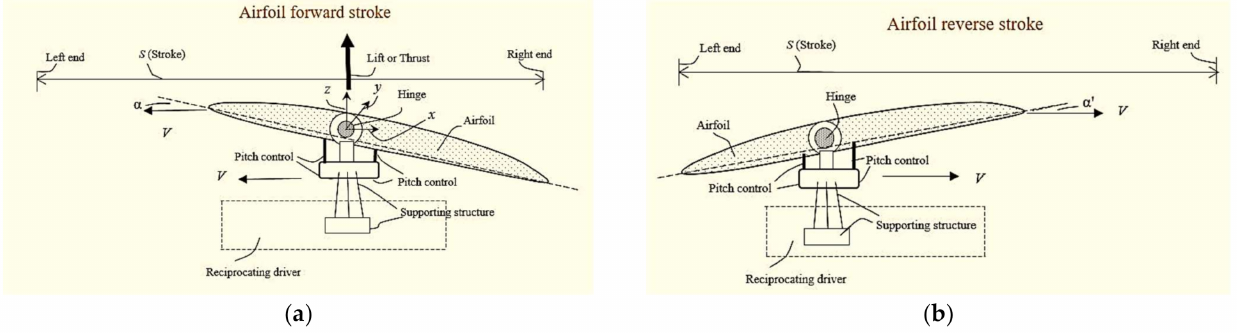
Figure 4. Schematic illustration of a reciprocating wing cycle. Reprinted from [14]: ( a ) Forward stroke and ( b ) Reverse